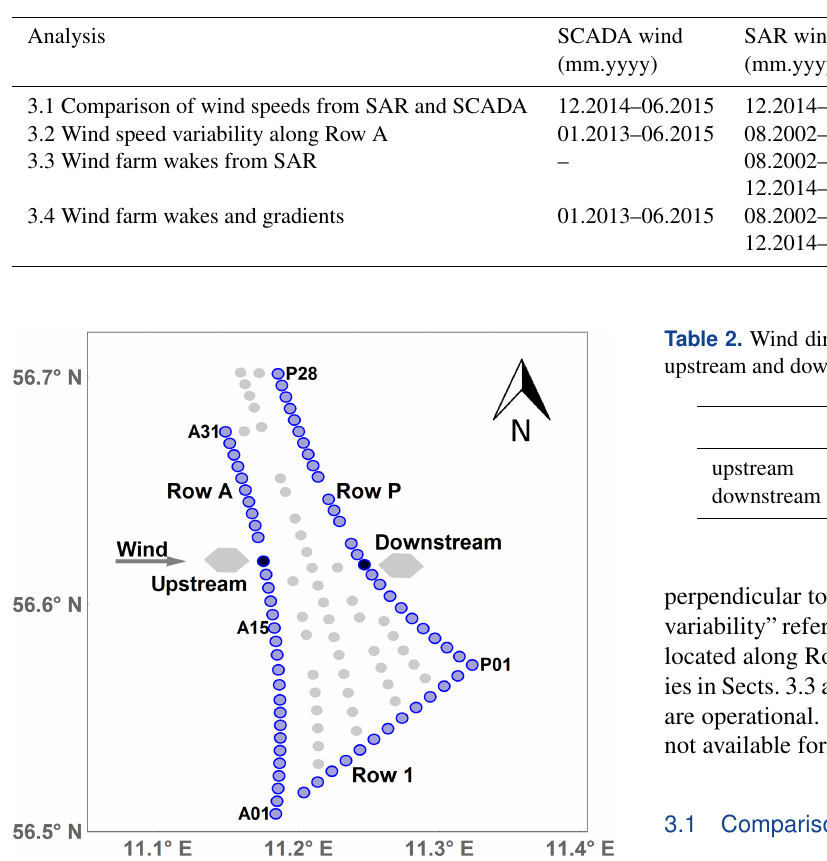
Table 1. Overview of the data sets and time periods used for the analysis.